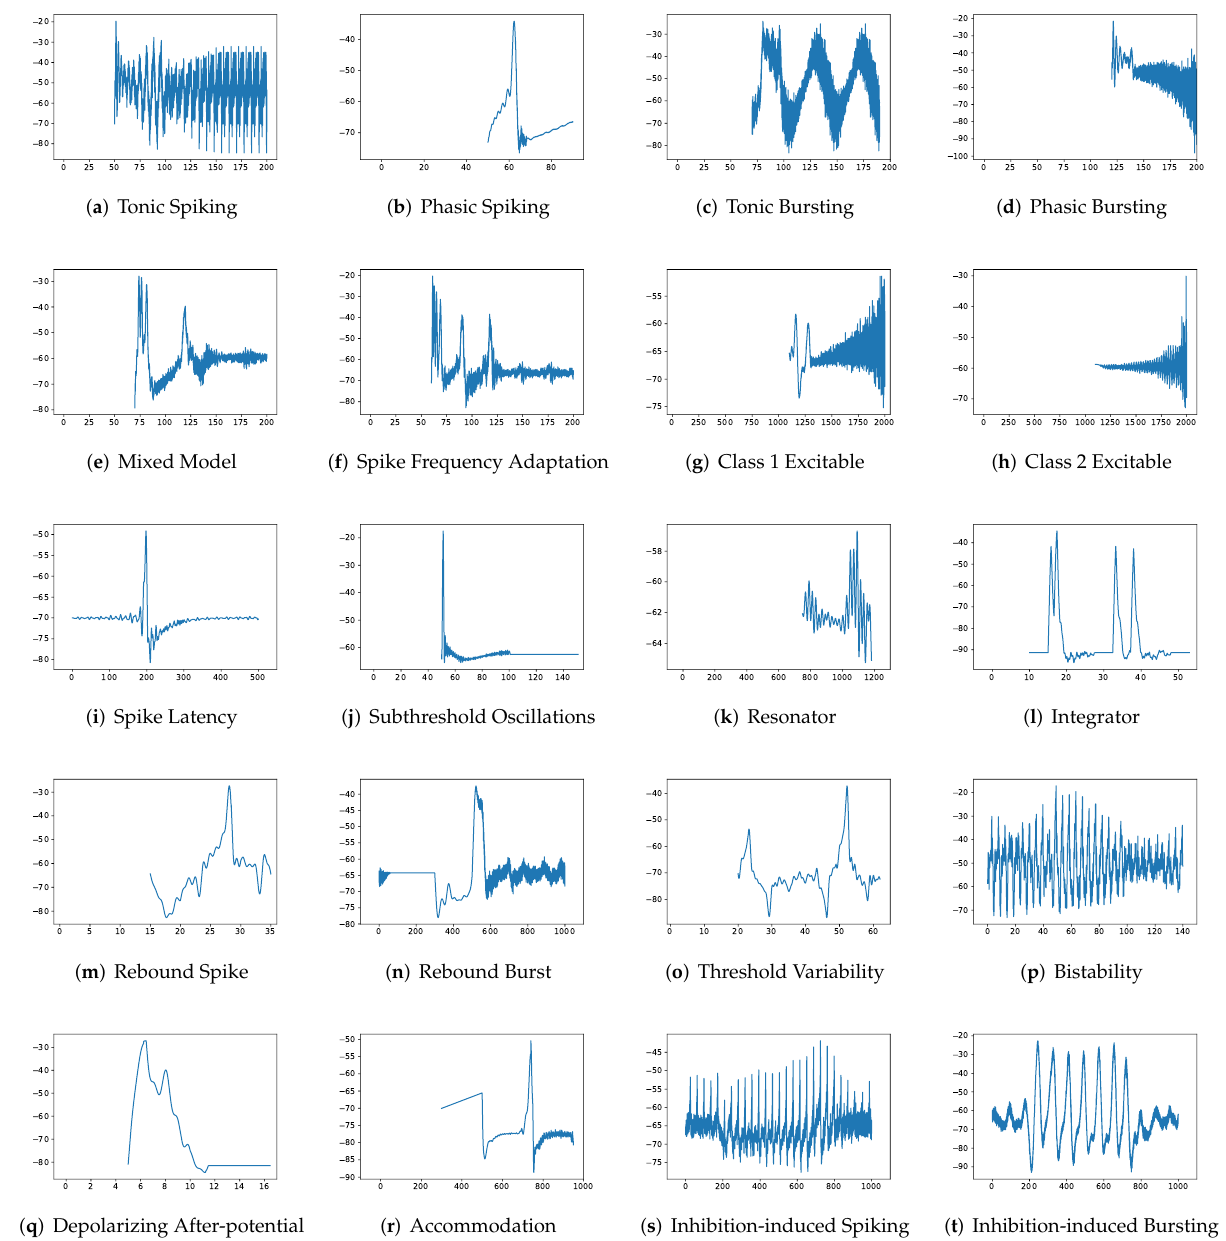
Figure 12. Membrane potentials of PCR, where y-axis is the membrane potential (mV) and x-axis is the time (ms).